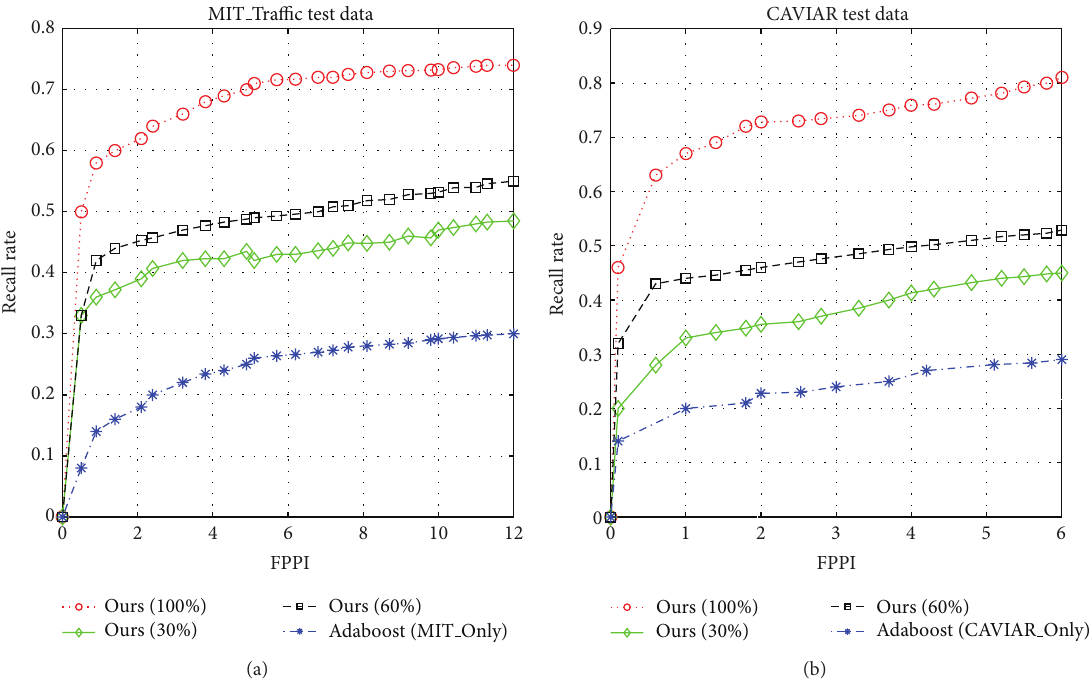
Figure 2: Results on MIT Traffic scene (a) and CAVIAR scene (b). (a) and (b) compare with Adaboost algorithm trained only on the target domain dataset and our approach trained on different numbers of the source data.